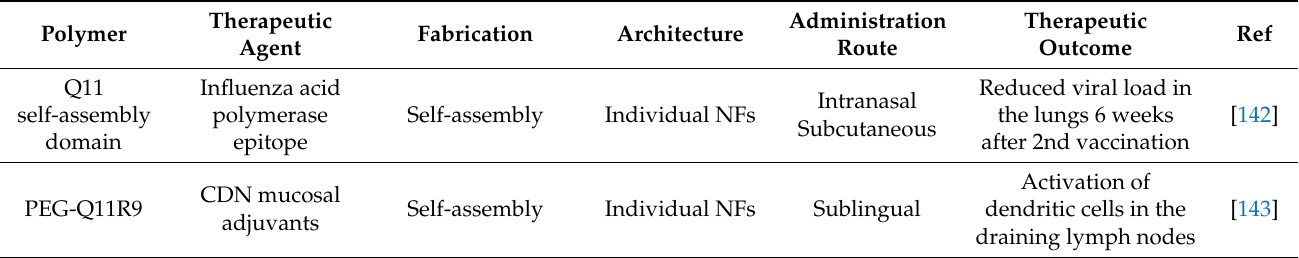
Table 3. Nanofiber systems used for the delivery of therapeutic protein and